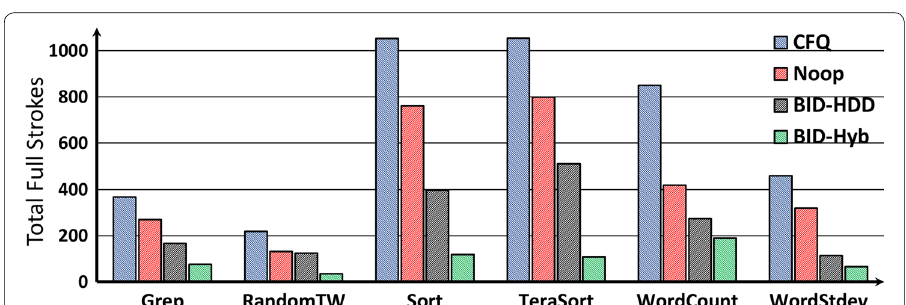
Fig. 17 Cumulative disk head movement